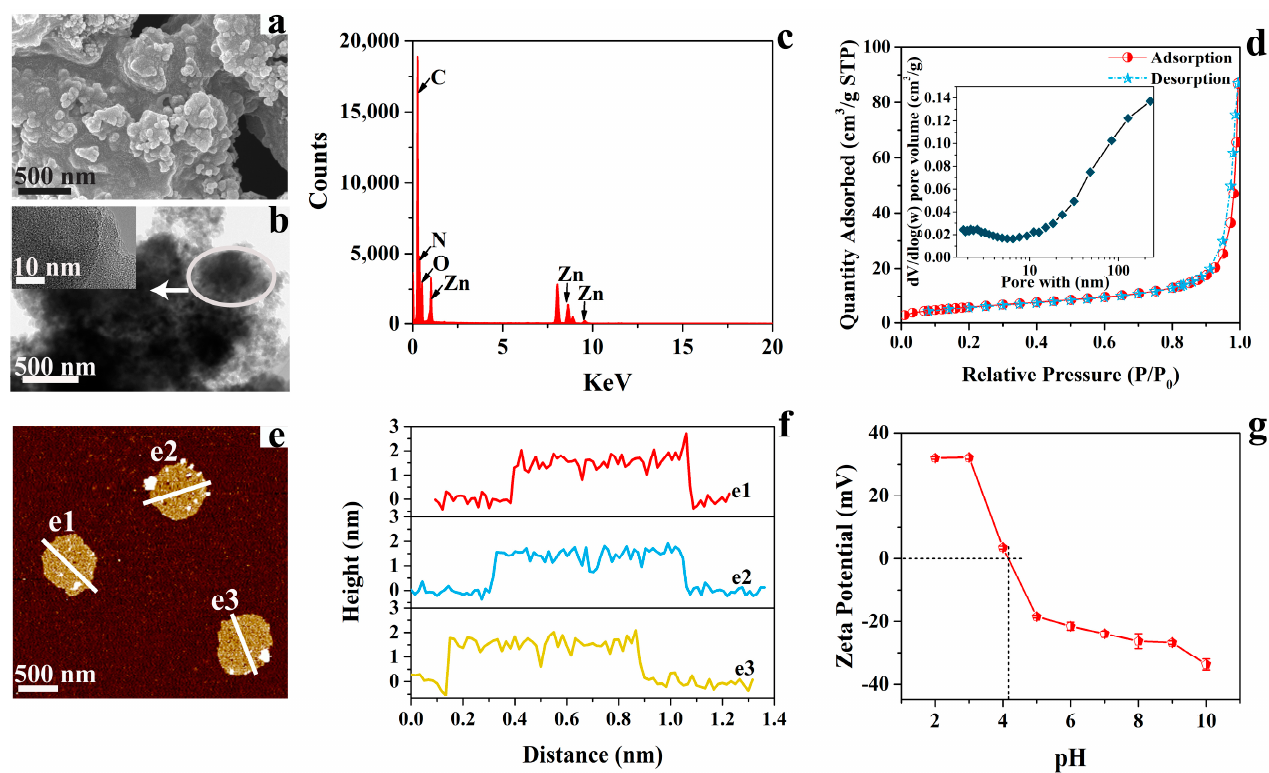
Figure 1. ( a ) SEM image, ( b ) TEM and HRTEM (inset) images, ( c ) TEM EDS spectrum, ( d ) nitrogen adsorption isotherms and the pore size distribution curve (insert), ( e ) AFM image and ( f ) the corre ‐ sponding height distribution profile of N ‐ CM obtained from AFM image. ( g ) The zeta potentials of N ‐ CM in different pH environment.